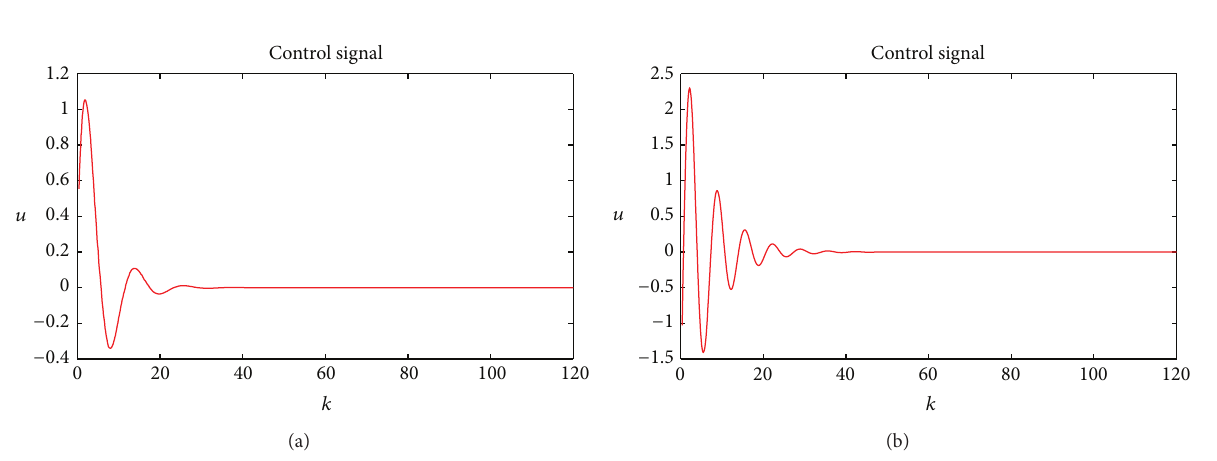
Figure 3: Comparison of the cost function ((a) using our method and (b) using the method proposed in [4]).